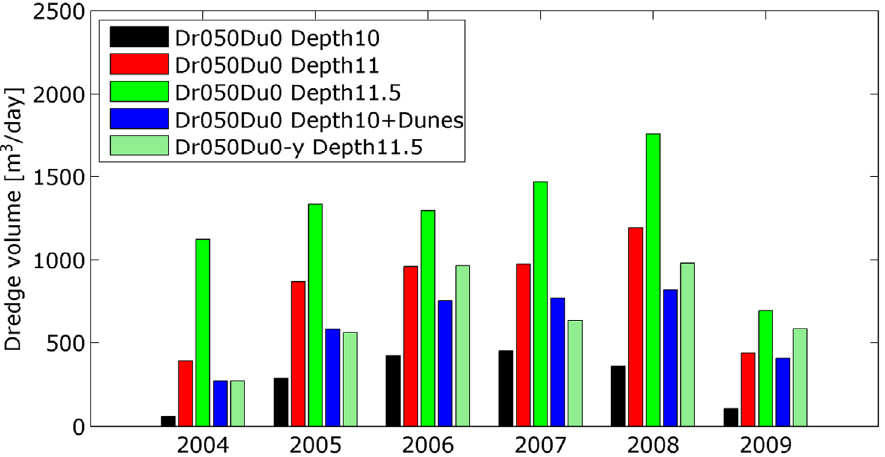
Figure 7. Dredging loads for different dredging-depth criteria. As dredging criterion